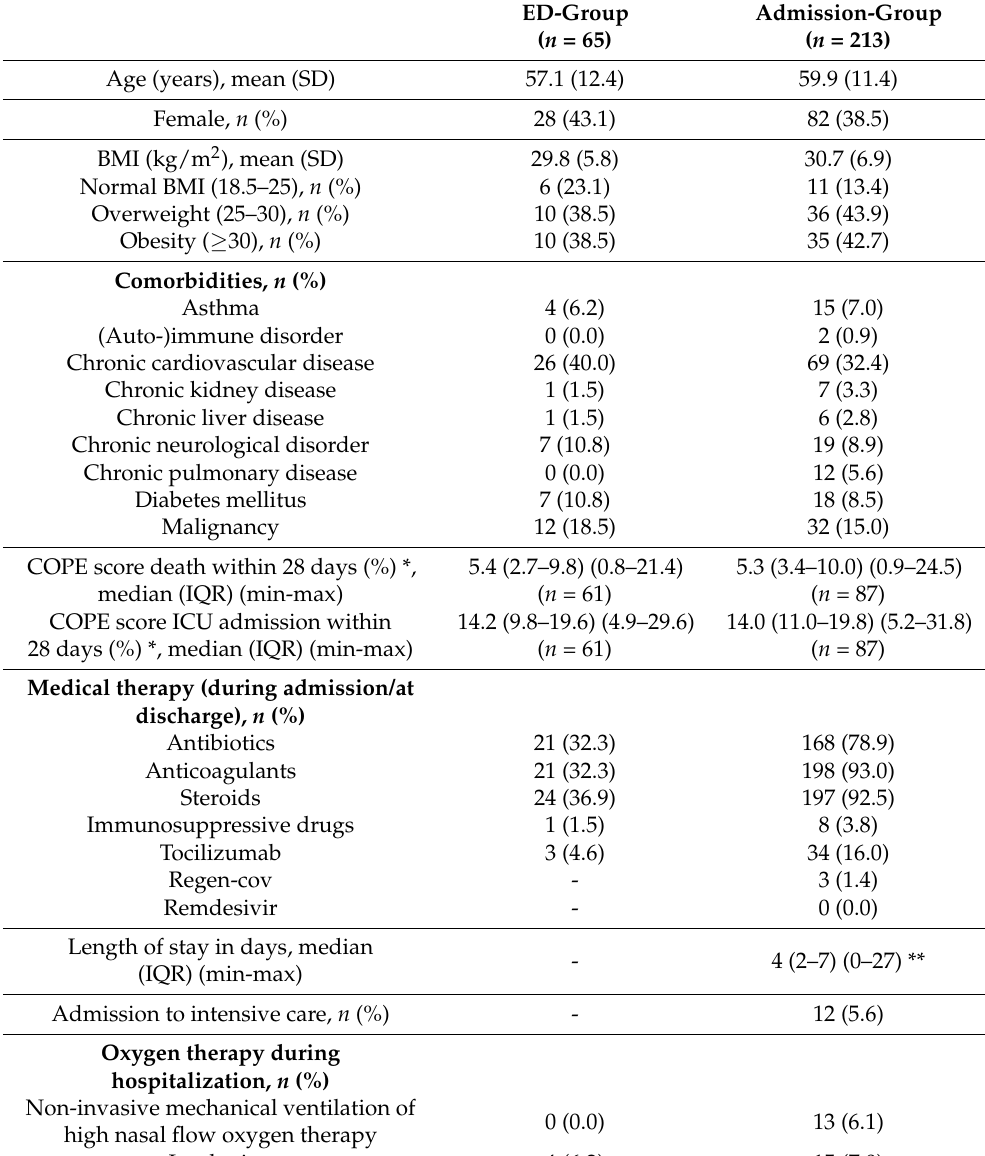
Table 1. Patient and disease characteristics of patients receiving home telemonitoring after ED assess- ment (ED group) and patients receiving home telemonitoring after hospital admission (admission group) at start of home